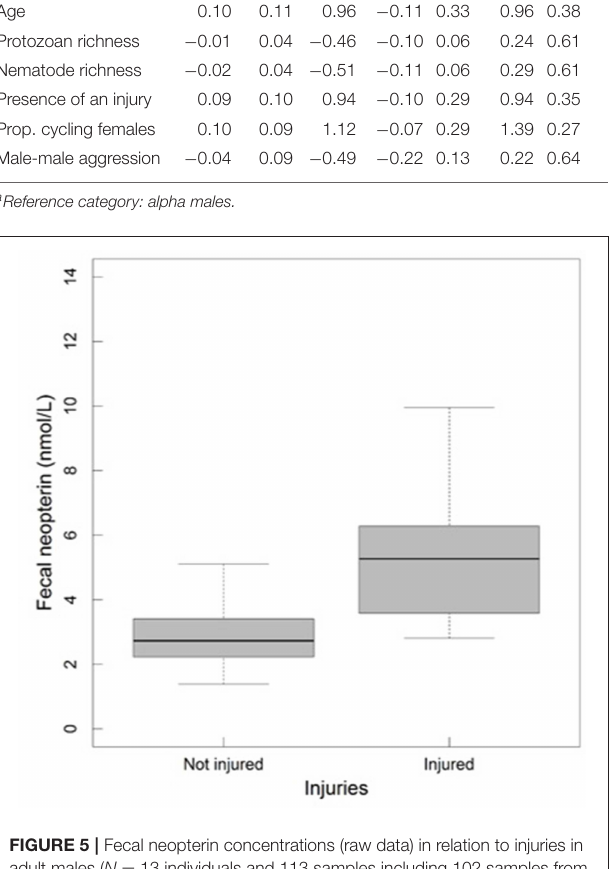
randomly distributed across plates, as were individual age, rank, or parasite